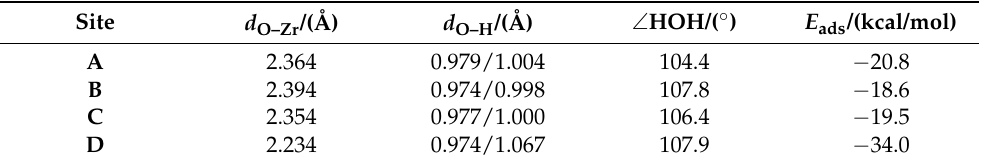
Table 2. Structural parameters of water adsorption on ZrO 2 surfaces.